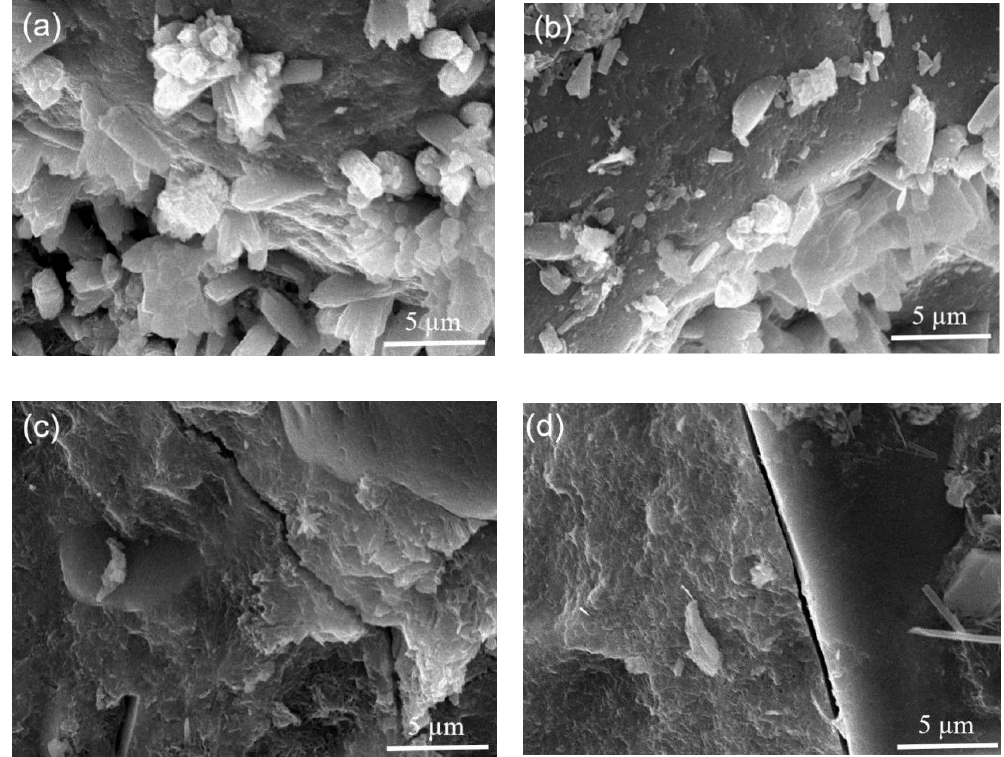
Figure 7. SEM images of ( a ) C, ( b ) 80C + 20ZP, ( c ) 60C + 40ZP and ( d ) 40C + 60ZP.